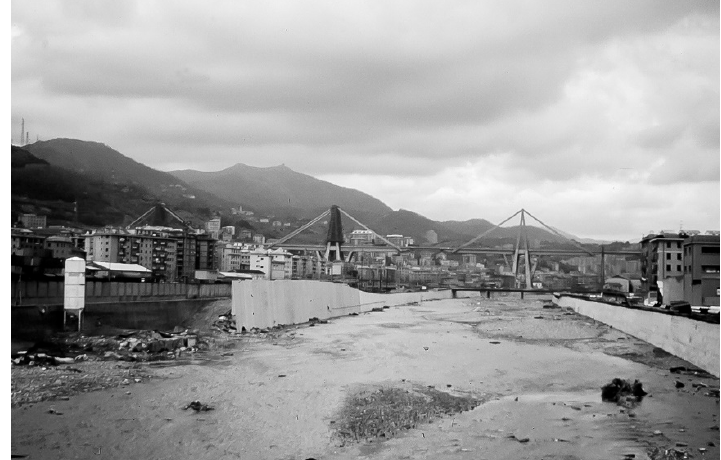
Figure 9. View of the 3 supports of the viaduct—No. 11 with strengthened concreted cables, No. 10 with an additional steel cap and No. 9 without any structural changes (photo by Rymsza; 04.1993).